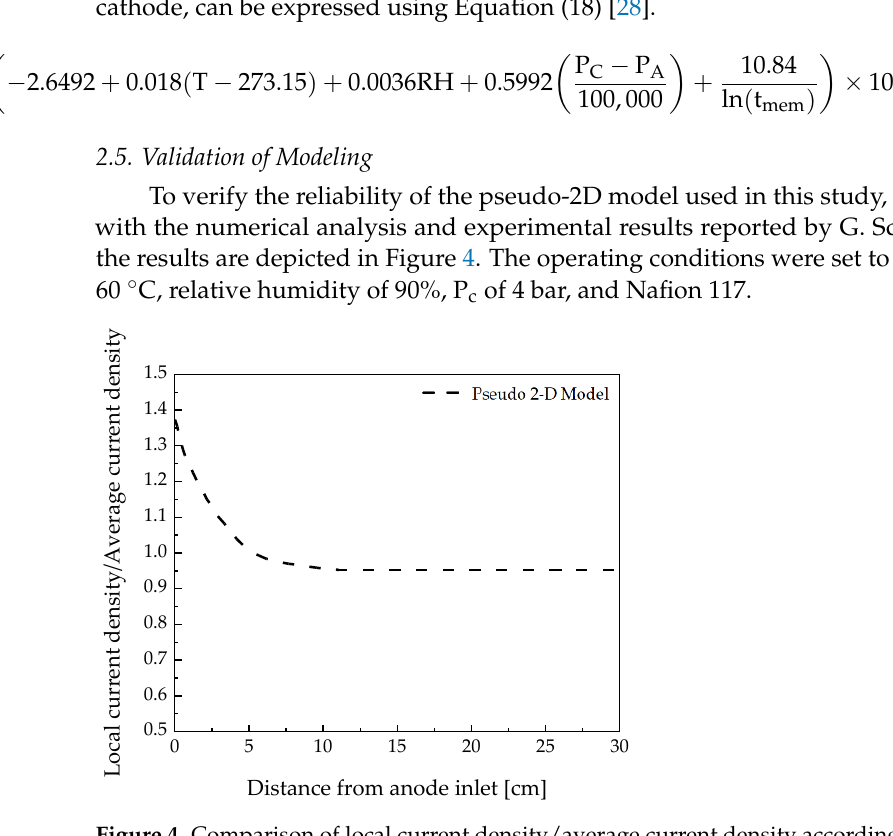
Figure 4. Comparison of local current density/average current density according to the anode inlet distance analyzed by the pseudo-2D model and reference model.